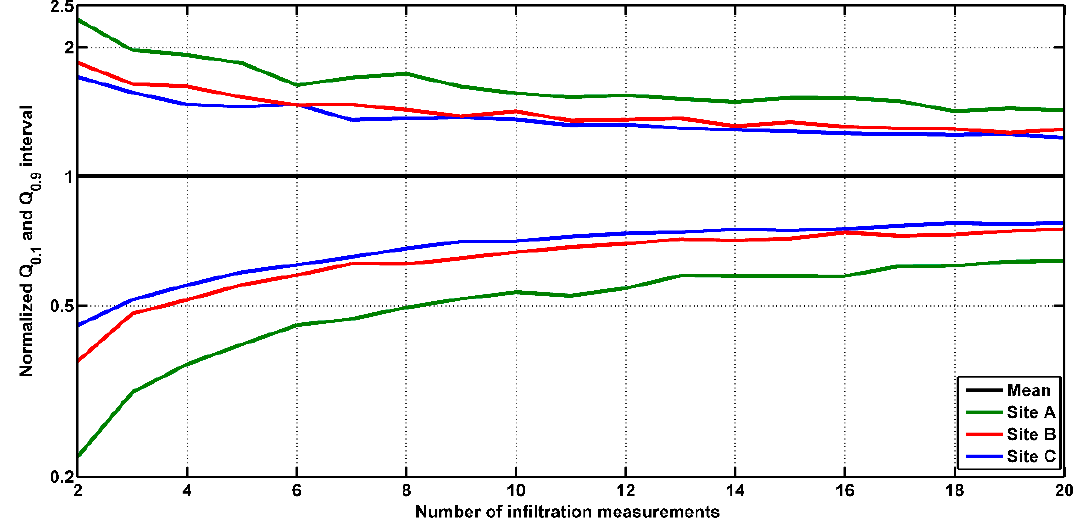
Figure 5. The quantiles Q 0.1 and Q 0.9 of K s arithmetic mean as a function of a number of measurements for sites A, B, and C (normalized by the mean m of the population).